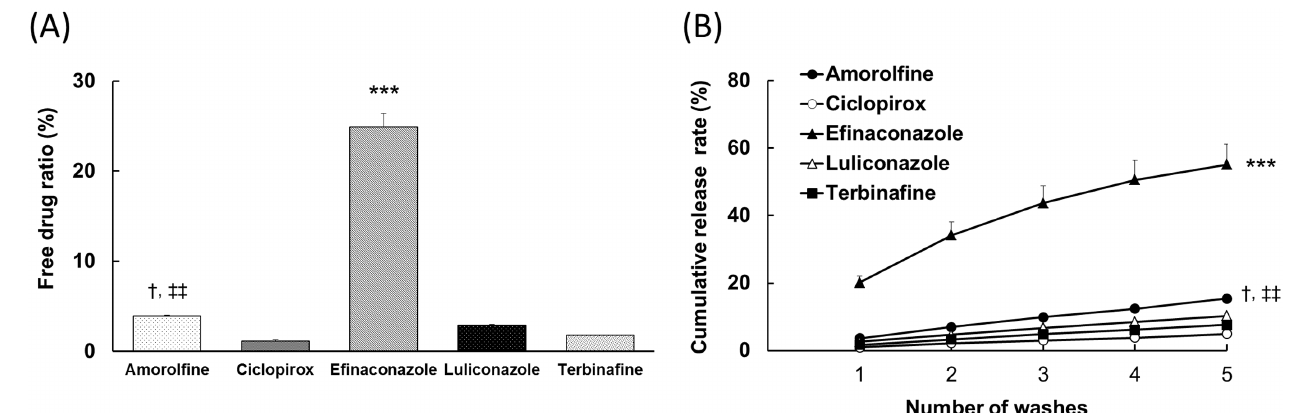
Fig 1. Affinities of five test drugs to keratin. (a) The percentage of the free drug in buffer after shaking at 37°C for 1 h. The graphs represent the mean + SD of three replicates. Tukey ’ s multiple-comparison test: *** , P < 0.001 versus amorolfine, ciclopirox, luliconazole and terbinafine; † , P < 0.05 versus terbinafine; ‡‡ , P < 0.01 versus ciclopirox. (b) The cumulative release of amorolfine, efinaconazole, luliconazole, and terbinafine. Each plot and bar represent the mean + SD of three replicates. Tukey ’ s multiple-comparison test: *** , P < 0.001 versus amorolfine, ciclopirox, luliconazole and terbinafine; † , P < 0.05 versus terbinafine; ‡‡ , P < 0.01 versus ciclopirox.